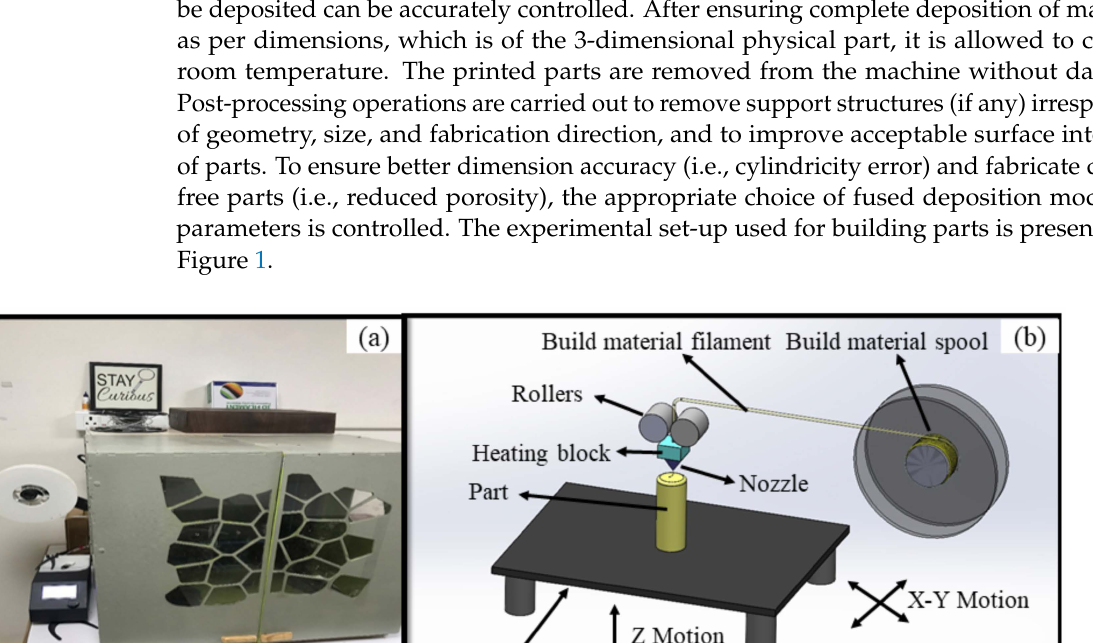
thickness (2, 3, 4 mm), infill density (20, 60, 100%), and print speed (30, 50, 70